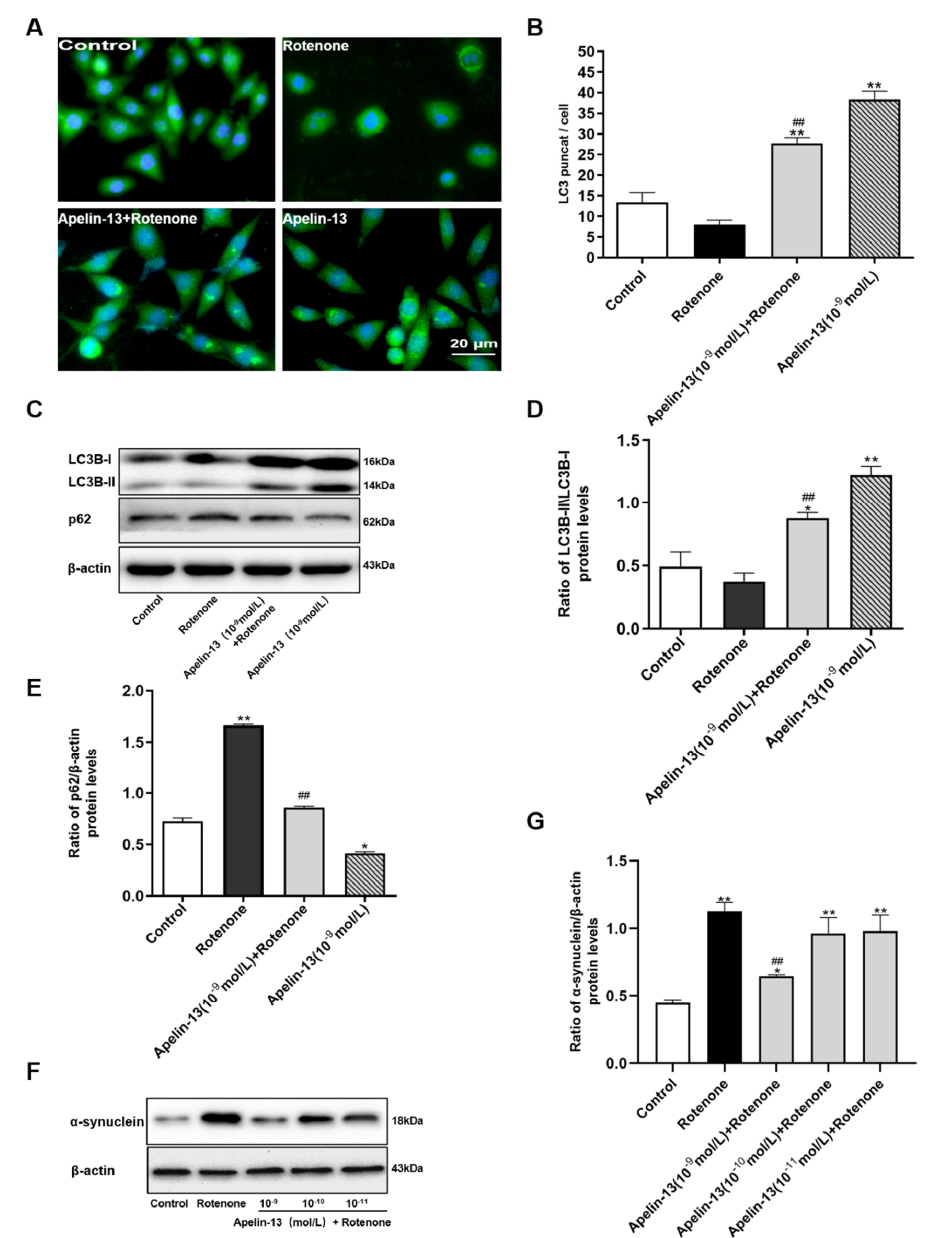
Figure 4. Effects of apelin-13 on rotenone-induced autophagy impairment in SH-SY5Y cells. ( A ) Fluorescent images were captured and processed. Cells in the control and rotenone groups exhibited a diffuse distribution of LC3B Ⅱ . The number of LC3B Ⅱ puncta increased in the presence of apelin-13, with or without rotenone treatment. Bar = 20 μ m. ( B ) Statistical analysis of LC3 puncta/cell. Data are presented as mean ± SEM of three replications. ** p < 0.01 compared with the control; ## p < 0.01 compared with the rotenone group. ( C – E ) Western blot was applied to detect the levels of LC3B-II / LC3B-I and p62. Apelin-13 rescued the ratio of LC3B-II / LC3B-I and blocked the expression of p62 in the rotenone-treated SH-SY5Y cells. ( F , G ) Western blot was applied to detect the expression of α -synuclein. Rotenone treatment led to a dramatic increase in α -synuclein levels in SH-SY5Y cells; however, apelin-13 pretreatment significantly reduced this increase. Data are presented as mean ± SEM of three replications. * p < 0.05; ** p < 0.01 compared with the control; ## p < 0.01 compared with the rotenone